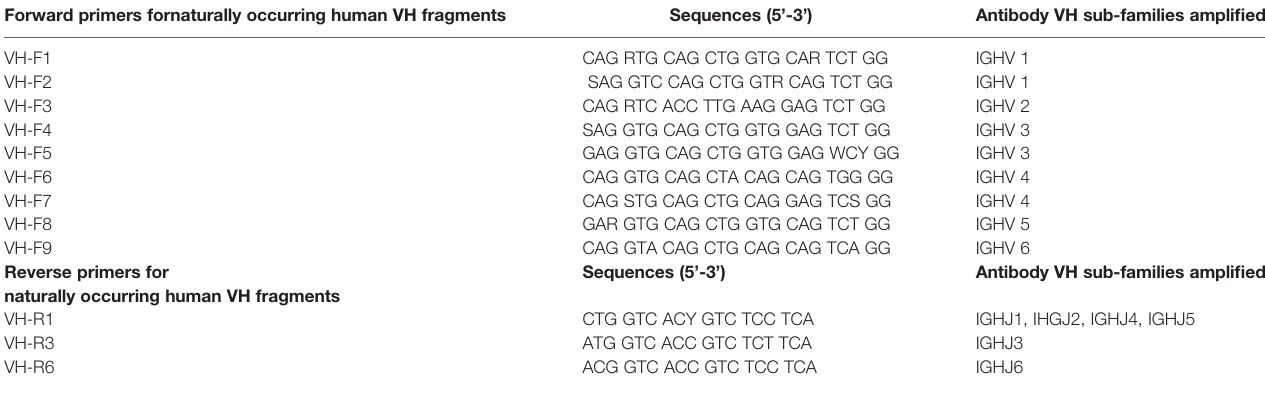
TABLE 1 | Primers for ampli fi cation of natural occurring full length VH gene repertoires. Forward primers fornaturally occurring human VH